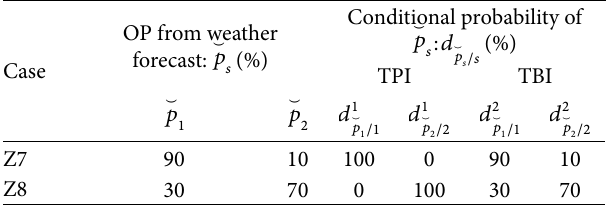
Table 10: Different occurring probability (OP) and conditional probability distribution of TBI.